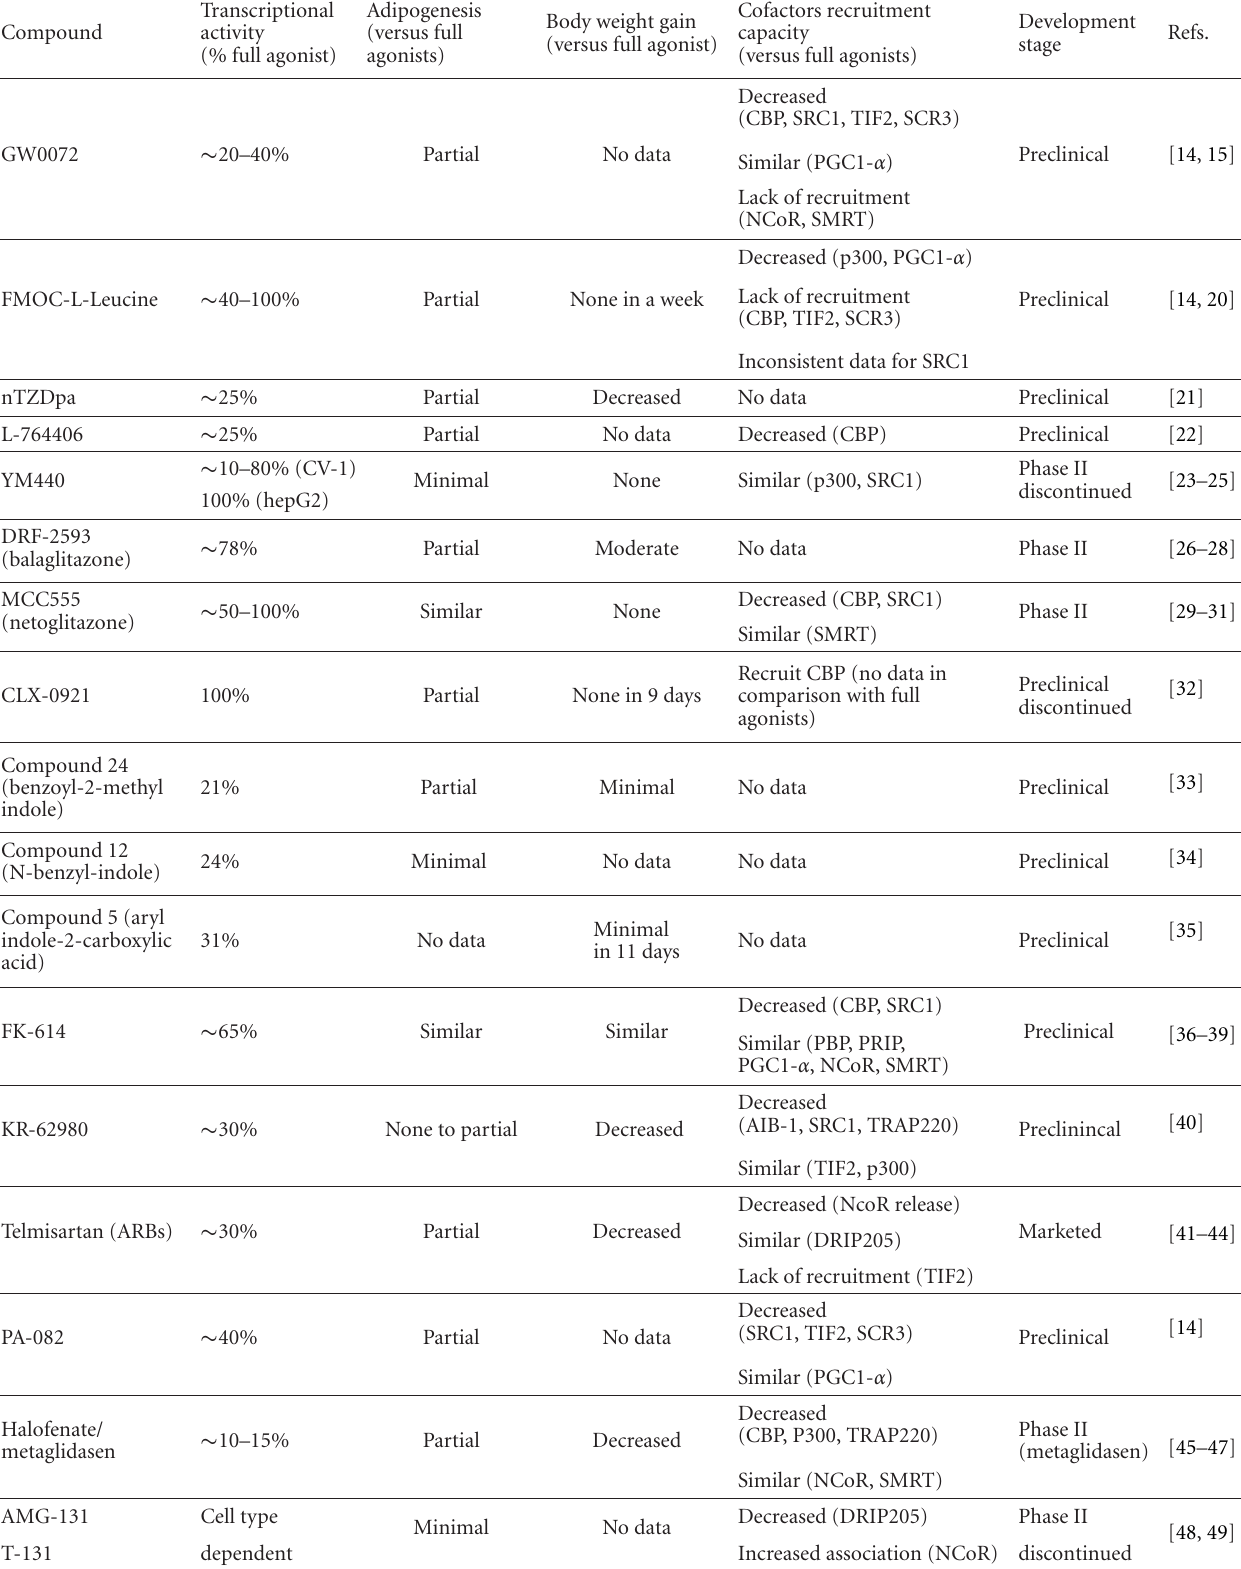
Table 1: Investigational SPPAR γ M ligands for the treatment of type 2